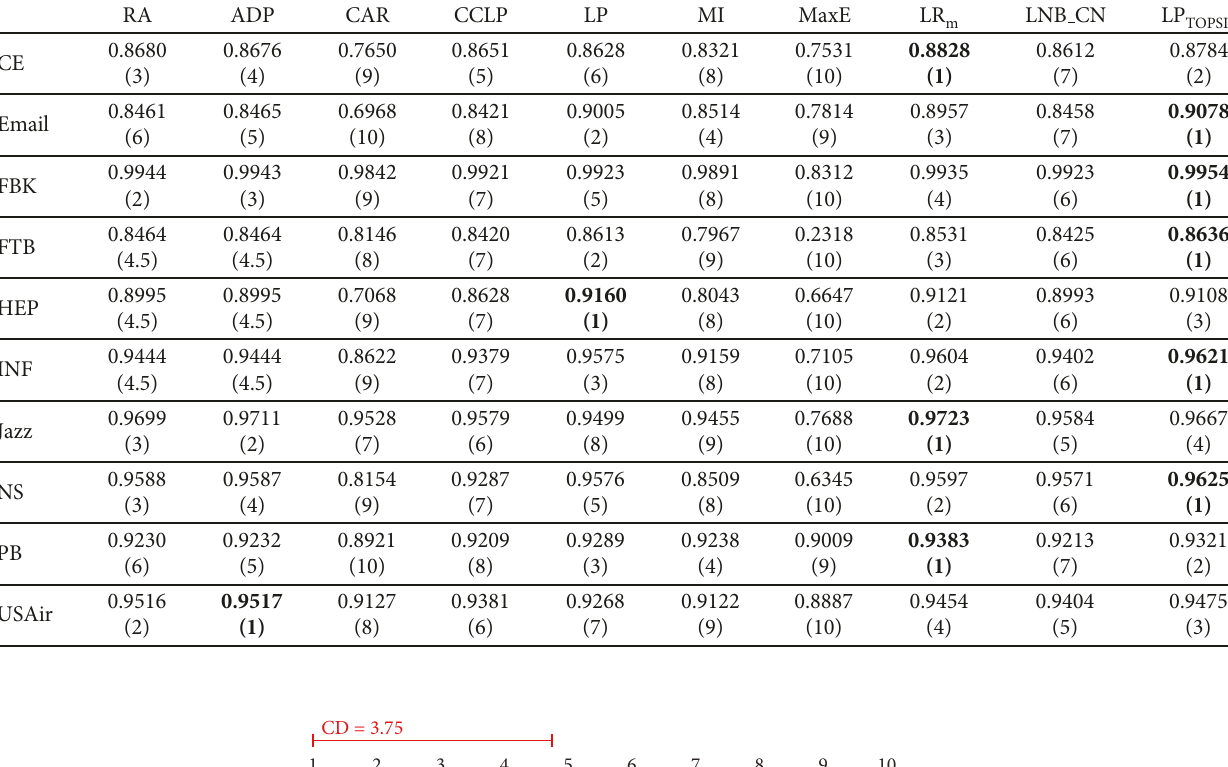
Table 3: AUC values of di ff erent methods on 10 networks. The results are the average of 50 independent implementations with E The best performance for each network is emphasized by boldface. The numbers in the round brackets are the ranks. In case of ties, average ranks are assigned.